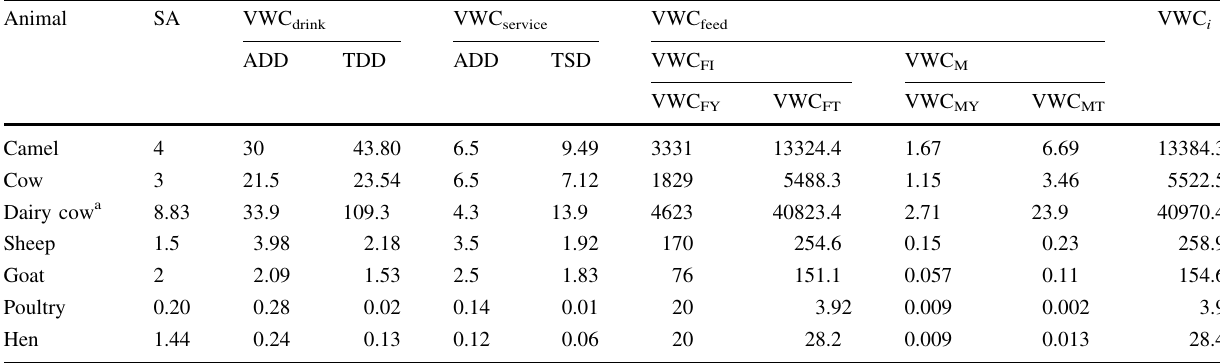
Table 4 Calculation of VWC for a livestock animal at the age of slaughtering Animal SA VWC drink